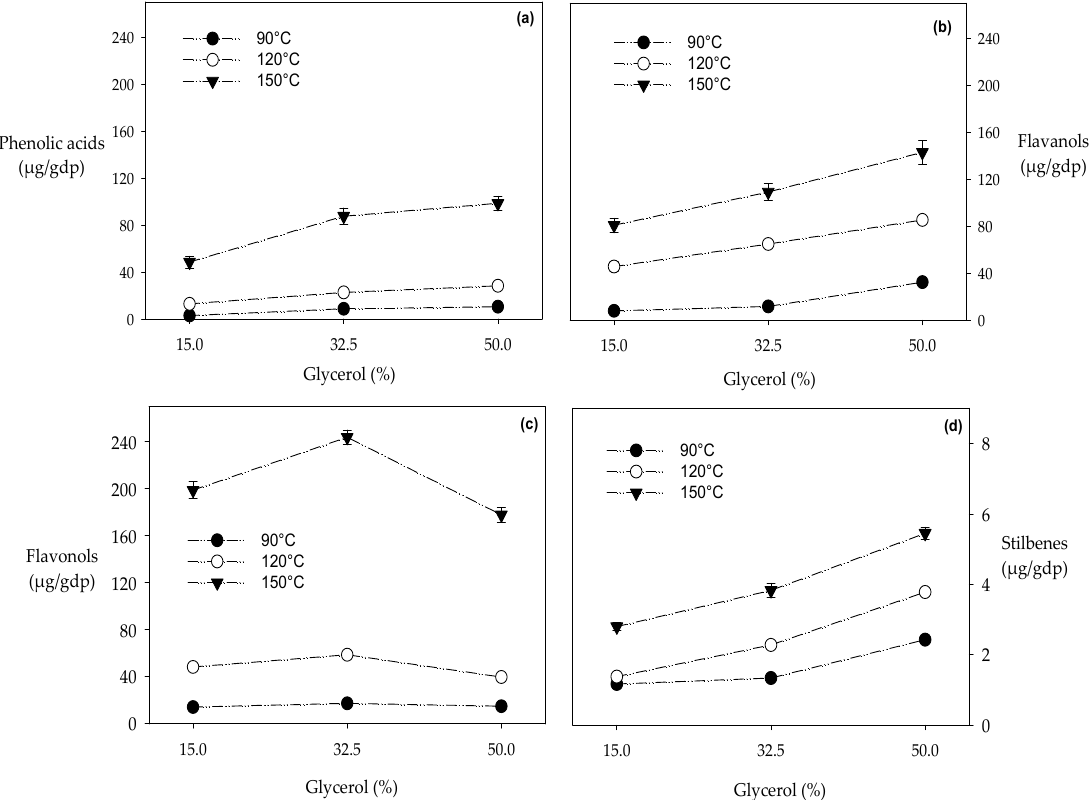
Figure 1. Effect of glycerol as a co-solvent during hot pressurized liquid extraction system (HPLE) to obtain extracts rich in ( a ) phenolic acids; ( b ) flavonols; ( c ) flavanols; and ( d ) stilbenes.